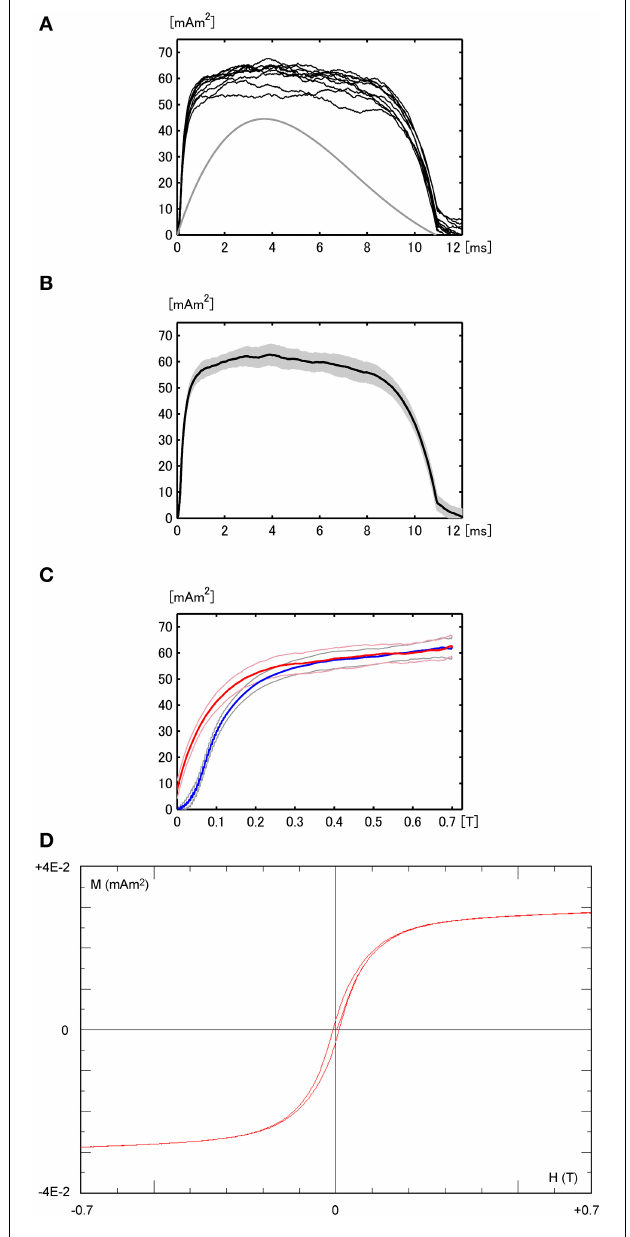
FIGURE 6 | (A) M–t curves from measurements repeated 10 times for sample OS2-2. The H-t curve (gray, not to scale) is provided for comparison. (B) Mean M–t curve and the error range (gray). (C) Mean M–H curve and associated error range for the increasing field (blue) and reducing field (red). (D) Hysteresis loop of OS2-2 (30.5mg) including magnetization after initial demagnetization.